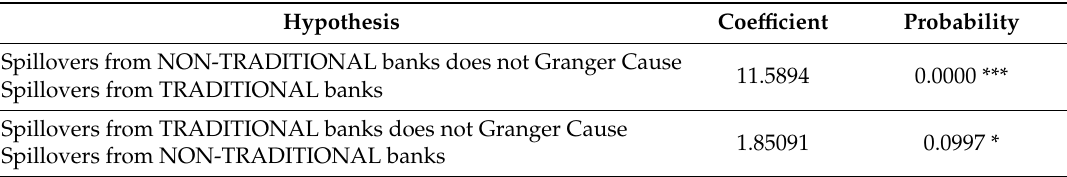
Table 8. Granger causality test for the income source